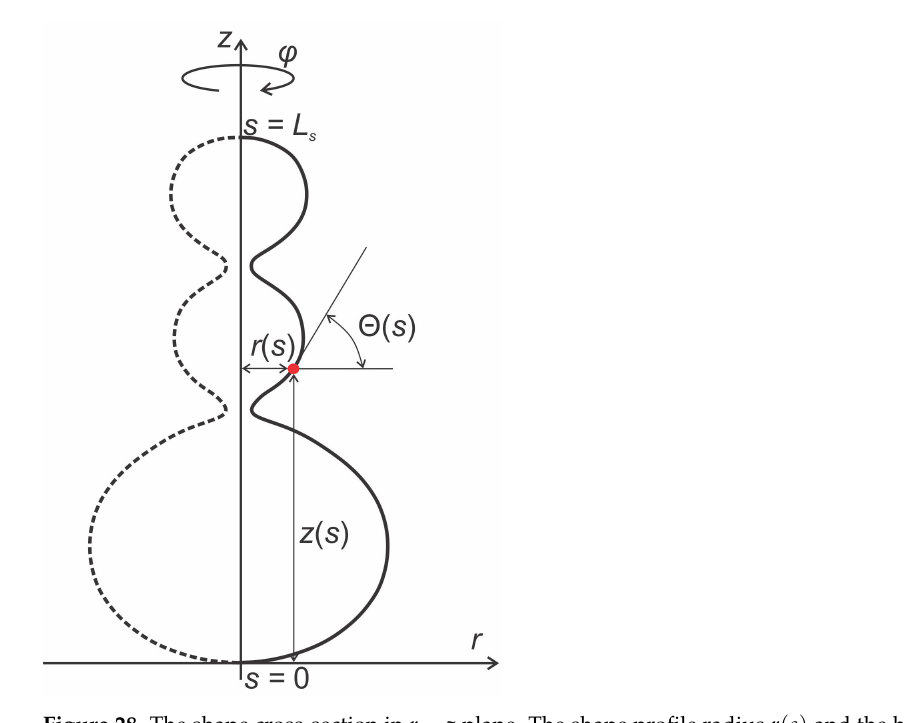
Figure 28. The shape cross-section in r − z plane. The shape profile radius r ( s ) and the height z ( s ) at the given arc length s are calculated from Θ ( s ) via Equations (55) and (56). L s is the length of the shape profile and ϕ is the angle of rotation around the z